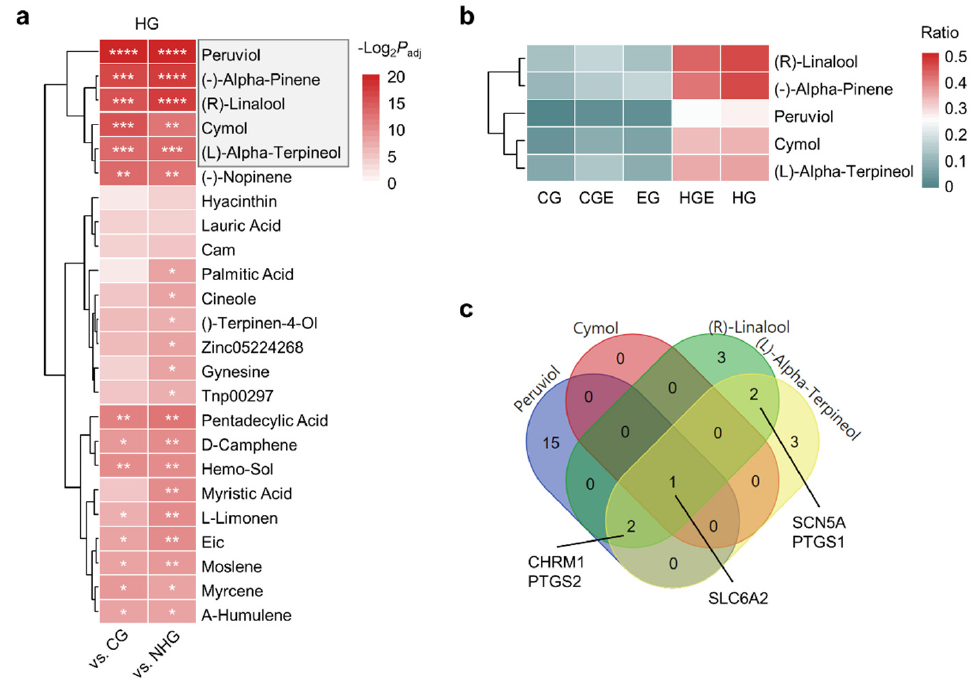
Figure 2. Enriched ingredients of herbs in the hot group. ( a ) Enrichment analysis of ingredients comparing the herbs of the HG with those of the CG and NHG. The P adj values were obtained by Benjamini–Hochberg multiple testing correction after hypergeometric tests. The top five hot-specific ingredients are denoted with the gray box. * p adj < 10 − 2 , ** p adj < 10 − 3 , *** p adj < 10 − 4 , **** p adj < 10 − 5 . ( b ) Ratio of hot-specific ingredients included in the herbs of the CG, CGE, EG, HE, and HG. ( c ) Venn diagram of the target genes of the hot-specific ingredients. The common target genes are indicated in their groups using lines. Lists of all the target genes are provided in Supplementary Table S3.